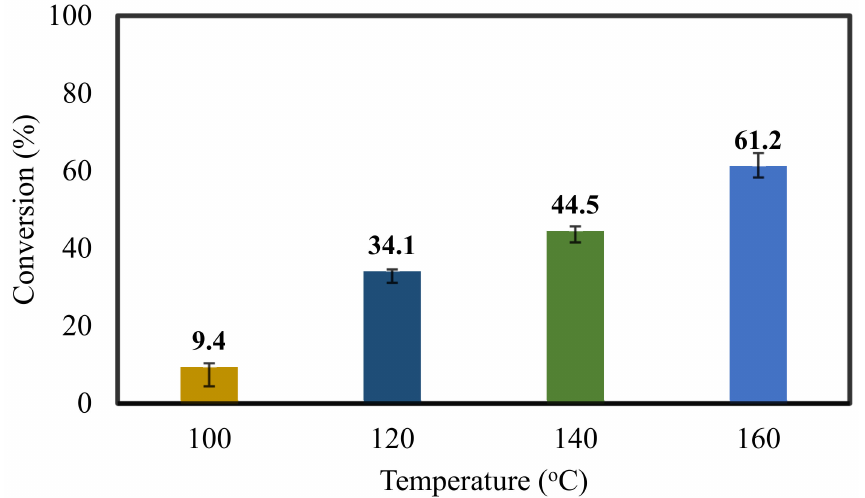
Figure 10. Influence of the reaction temperature on furfural conversion. Conditions: furfural (10 mmol), base (Et 3 N) (10 mmol), formic acid (20 mmol), @PdCassCat catalyst amount (20 mg), time (24 h).